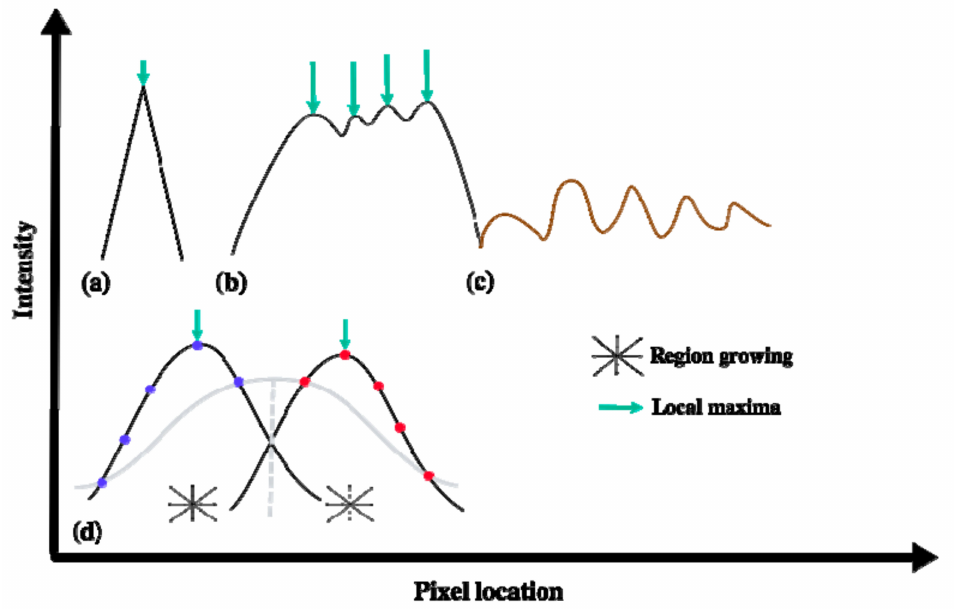
Figure 1. Intensity profiles. ( a ) A coniferous tree with a single maximum; ( b ) A broad-leaved tree with several local maxima; ( c ) A noisy background; ( d ) Represents the fitted Gaussian functions after region growing between two interlocked trees, colored blue and red. The grey curve is obtained if the Gaussian function is fitted to all points, whereas the black curves are obtained if region growing is applied on the two separate tree